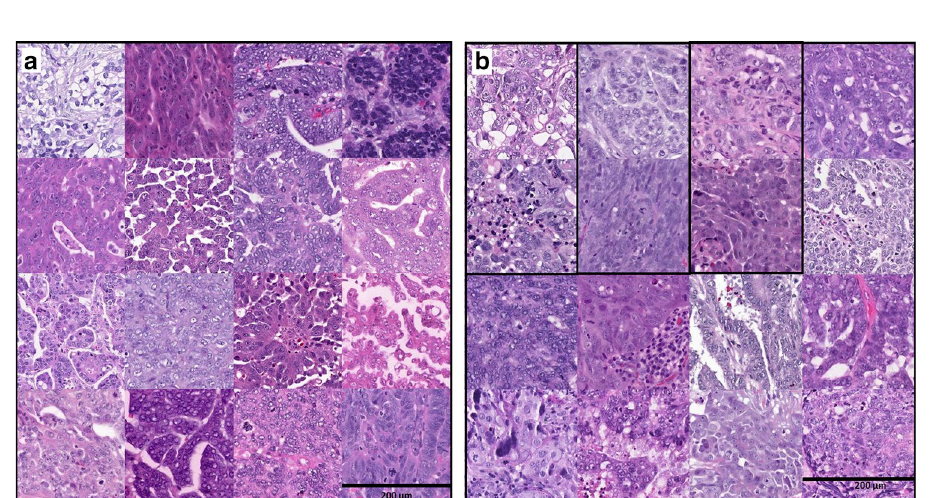
Figure 2. ( a ) Representative digital biomarkers for short PFI. Each tile (970 × 996px) is from a separate training set WSI and separate tumor. Each tile represents a region identified by NN2 as being highly associated with PFI-S, and that was annotated for inclusion in NN3 training. ( b ) Representative digital biomarkers for long PFI. Each tile (970 × 996px) is from a separate training set WSI; tiles from the same tumor are indicated within boxes. Each tile represents a region identified by NN2 as being highly associated with PFI-L, and that was annotated for inclusion in NN3